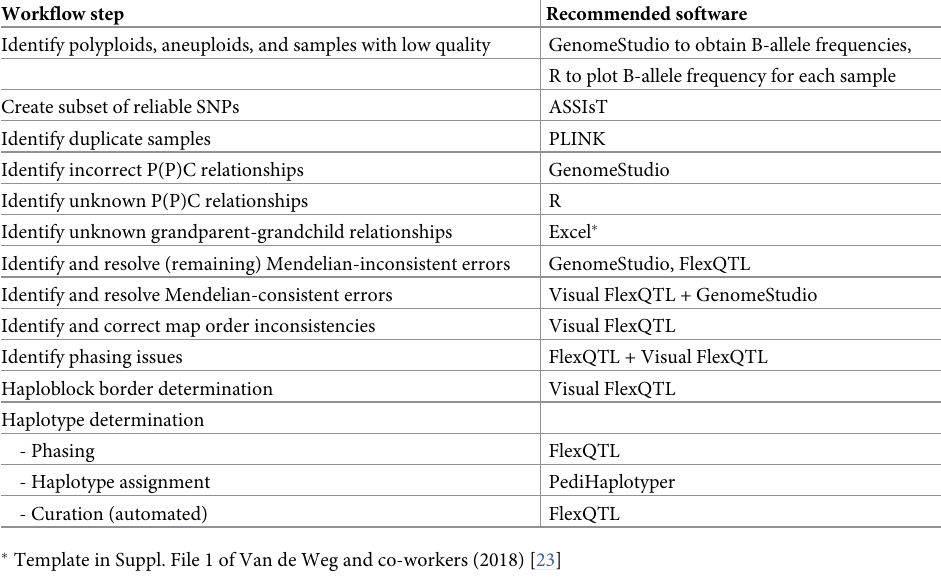
Table 4. Recommended software for each step of the genetic marker data curation workflow when using Illumina Infinium SNP arrays. Workflow step Recommended